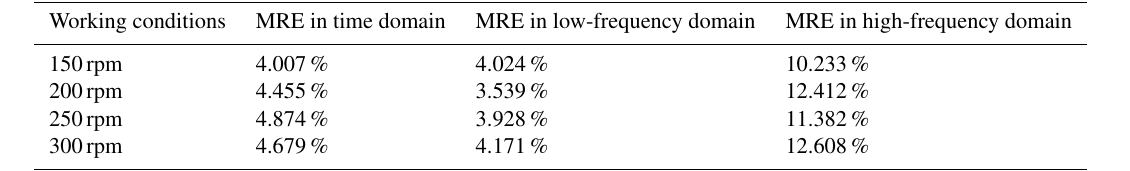
Table 3. Errors in the time domain and frequency domain under different working conditions.